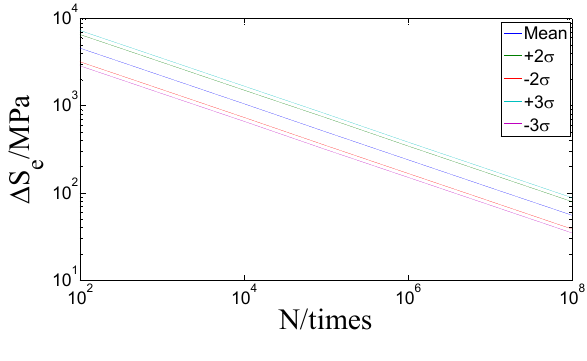
Figure 8. Master S ‐ N curve. Figure 8. Master S-N curve.